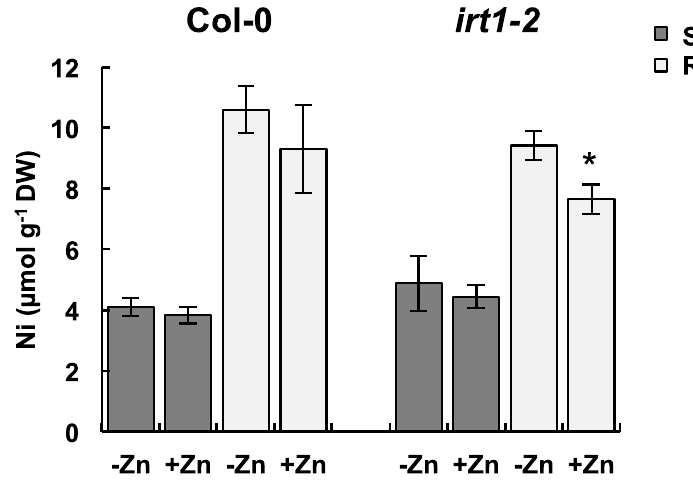
Figure 4. Ni accumulation in iron-regulated transporter1-2 ( irt1-2 ) under Zn-sufficient and -deficient conditions. One-week-old plants were grown on MGRL plates containing 25 μmol·L −1 NiCl 2 and 0 or 5 μmol·L −1 ZnCl 2 for 1 week. Asterisks denote significant differences ( p < 0.05, Wilcoxon-Mann-Whitney test) between the Zn-sufficient and -deficient conditions. The values represent means ± SD based on four independent